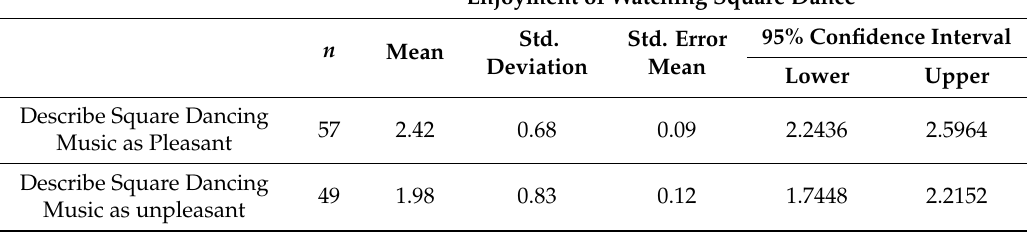
Table 4. Two-Sample T test with unequal variances comparing enjoyment of watching square dance with pleasantness of music.